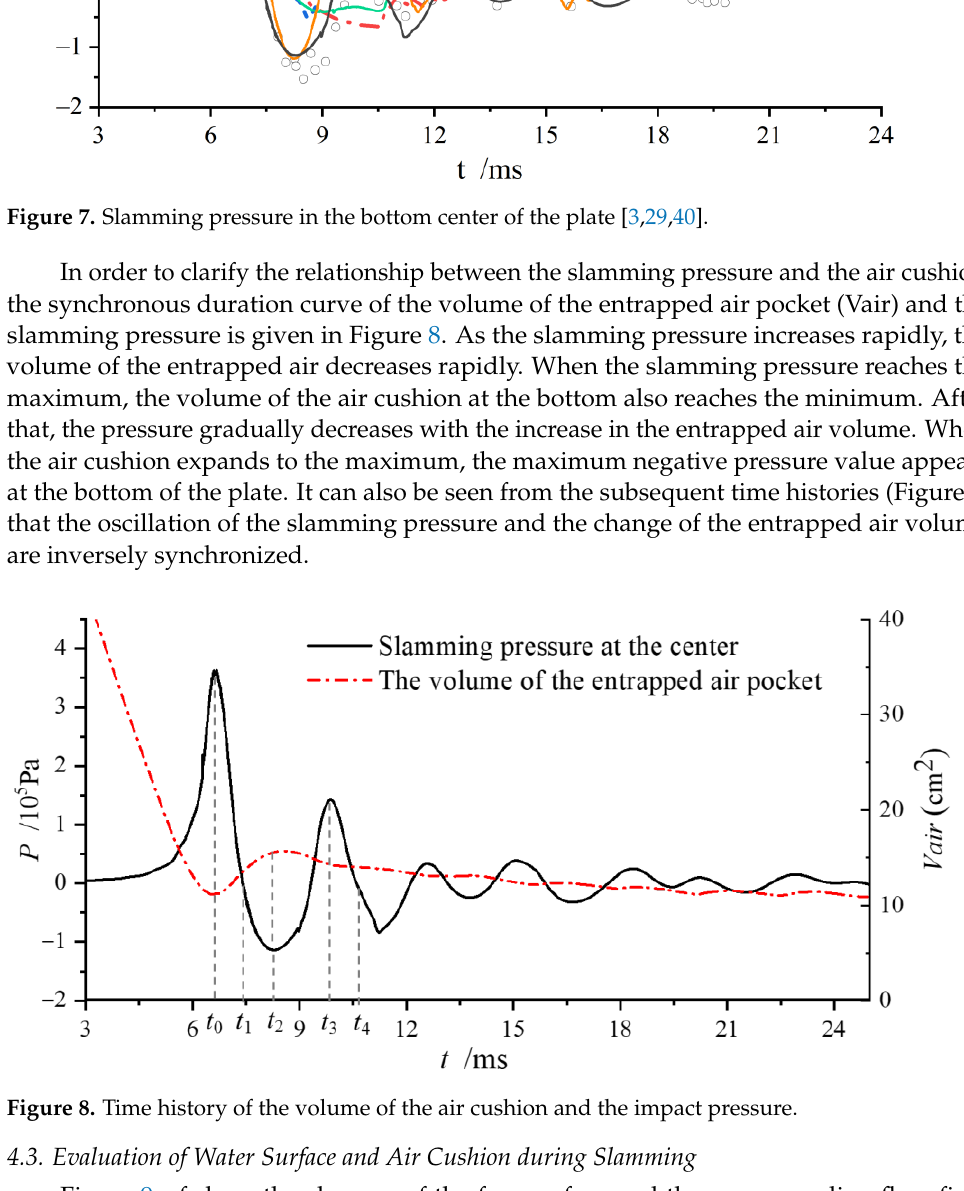
Figure 8. Time history of the volume of the air cushion and the impact pressure.